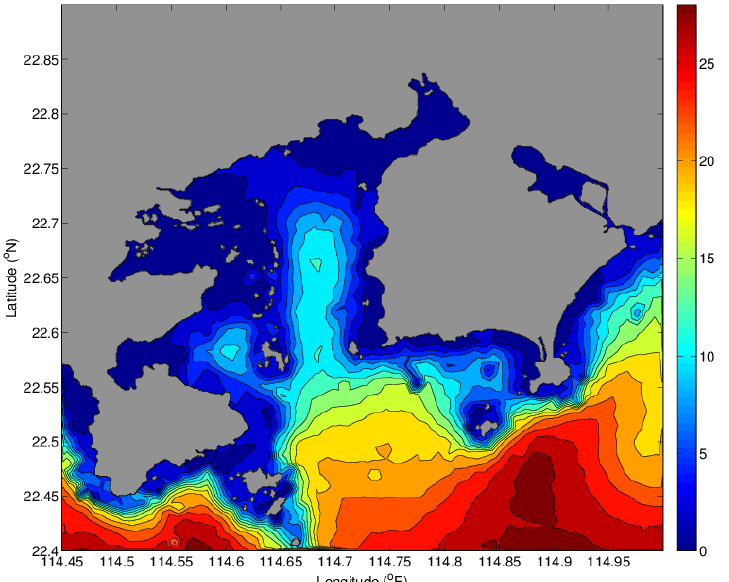
Figure 3. The MDP algorithm is tested in Daya Bay. The coastline is acquired from GSHHG, and the bathymetry is from a nautical chart.